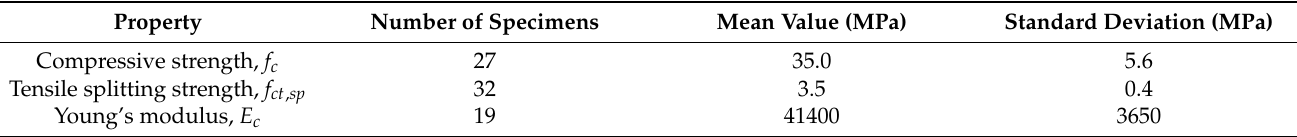
Table 2. Mechanical properties of concrete.